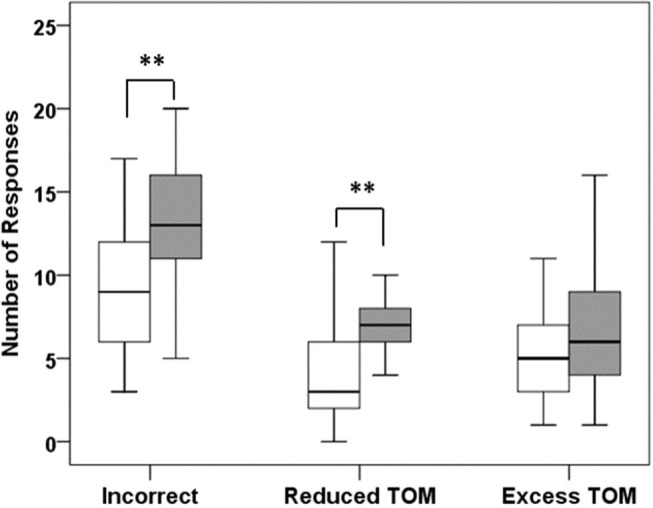
Results of the Movie for the Assessment of Social Cognition (MASC). Patients with HL (dark bars) made significantly more errors than healthy controls (white bars), mainly due to the choice of responses that indicated no or less theory of mind (reduced TOM). ** p < 0.01.